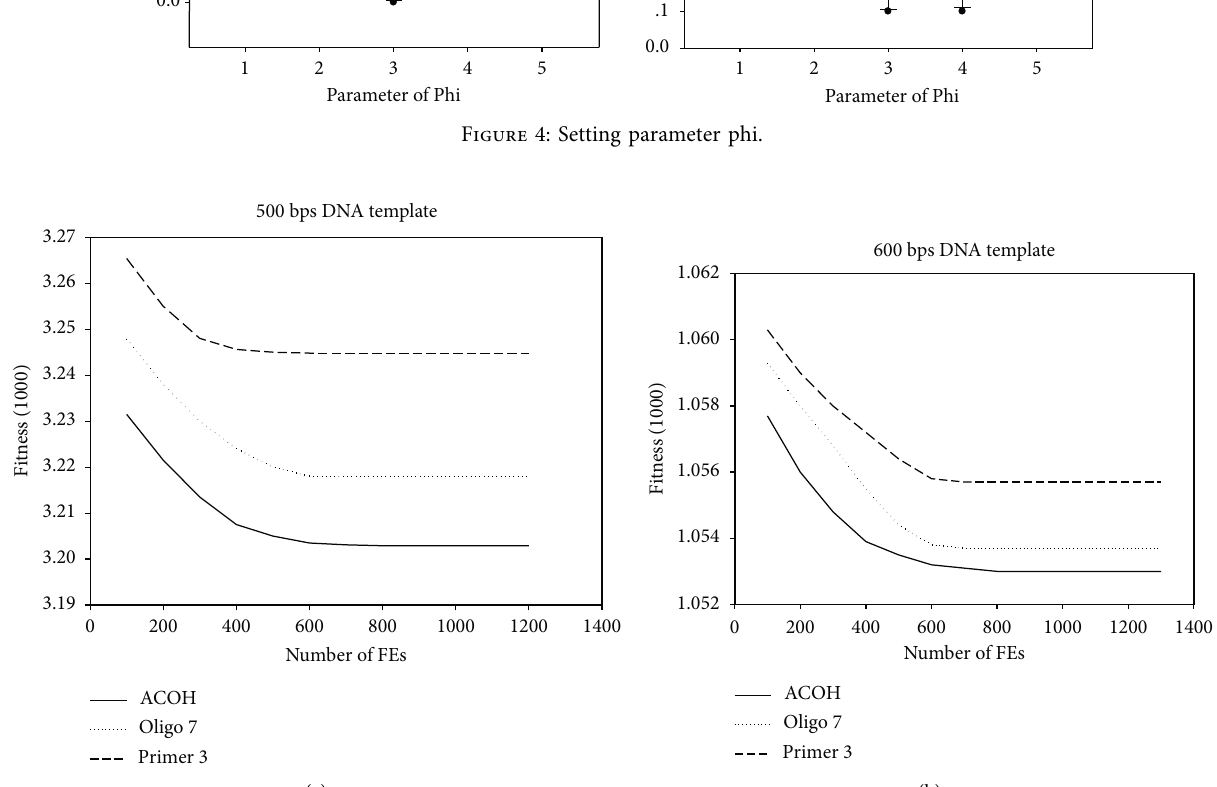
Figure 5: Convergence graphs for DPD. (a) 500bps DNA template. (b) 600 bps DNA